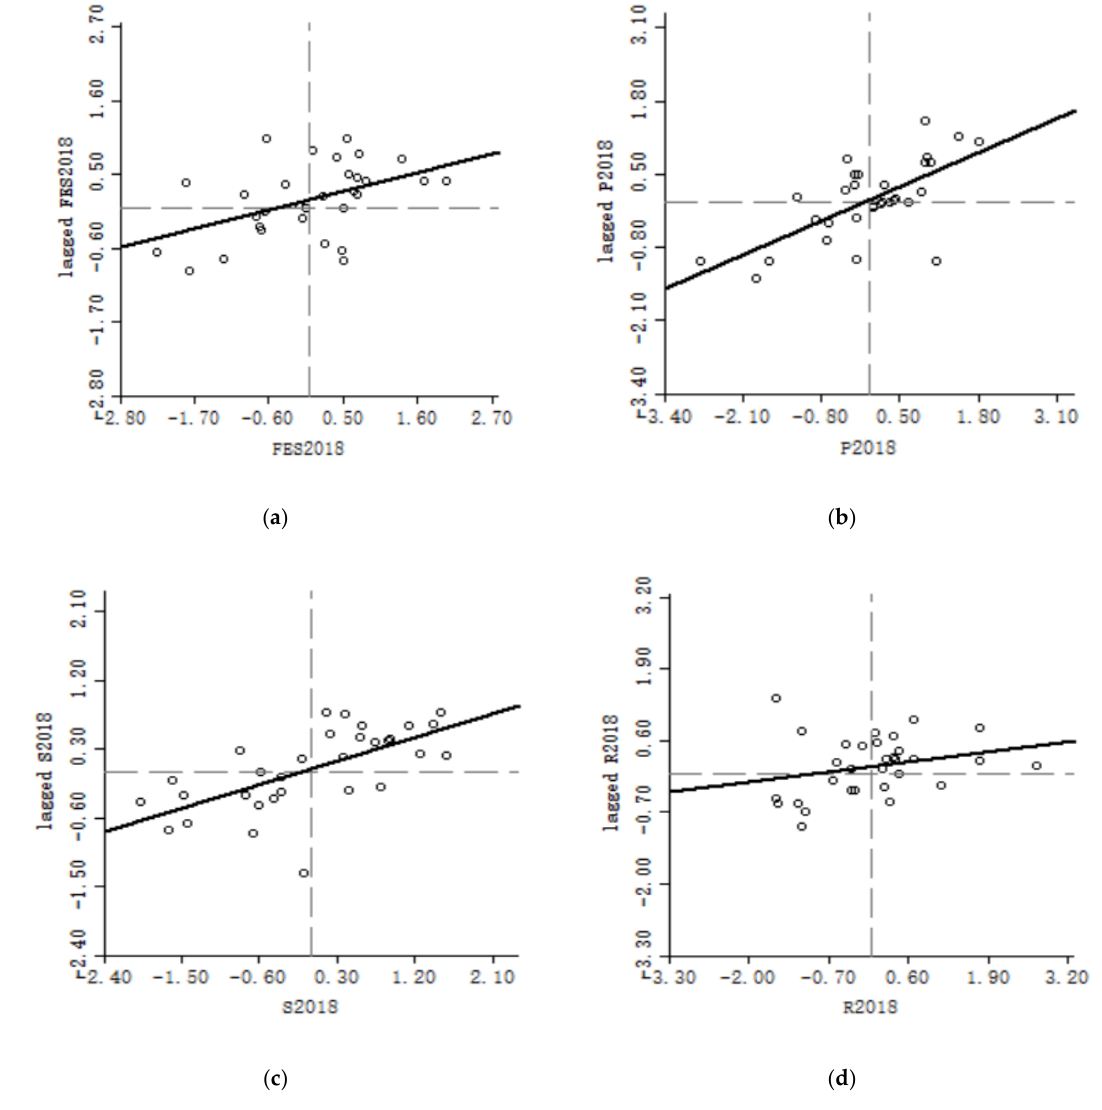
Figure 7. Moran scatter plot of pressure, state, response, and comprehensive index of forest ecological security. ( a ) Moran Scatter plot of comprehensive index; ( b ) Moran scatter plot of pressure index; ( c ) Moran scatter plot of state index; ( d ) Moran scatter plot of response index.